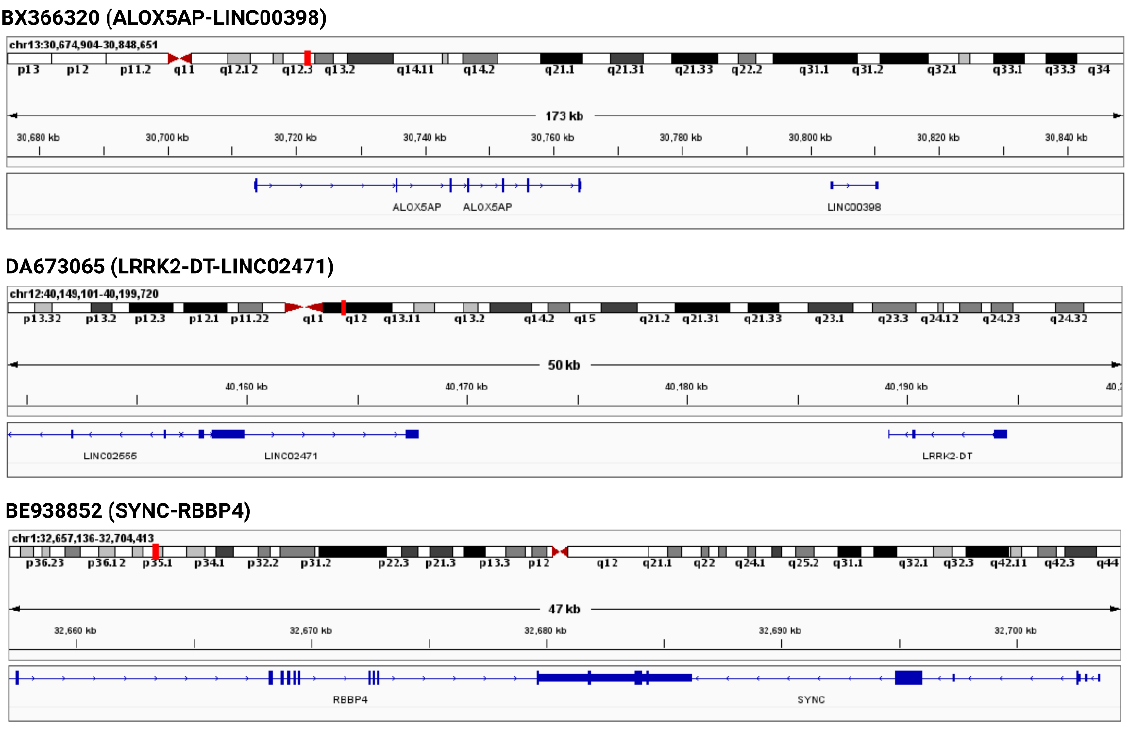
Figure 3. Genomic neighborhood analysis of the parental genes of severe COVID-19 specific recurrent chimeric transcripts. The two parental genes of chimeric transcripts adjacent to each other indicate the potentiality of cis-SAGe.